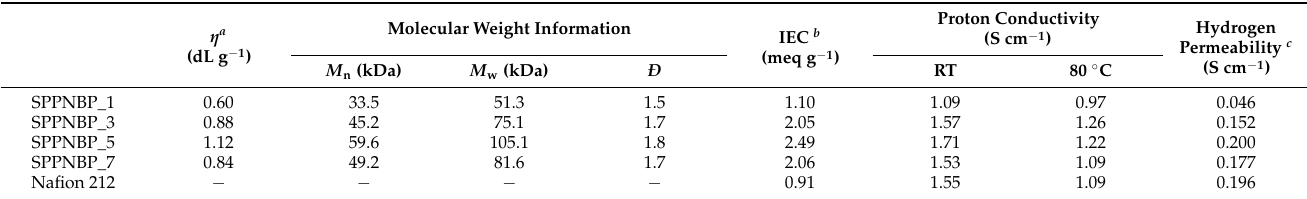
Table 1. The properties of SPPNBP multi-block copolymers and Nafion